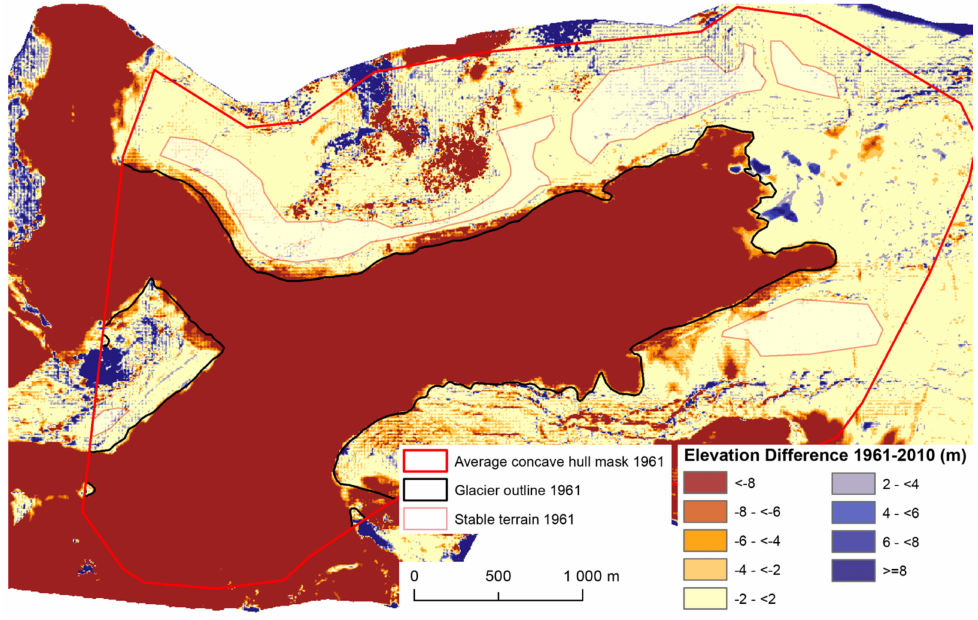
Figure 2. Example of a color-coded DTM differencing map for the period 1961–2010. The 1961 DTM was generated with